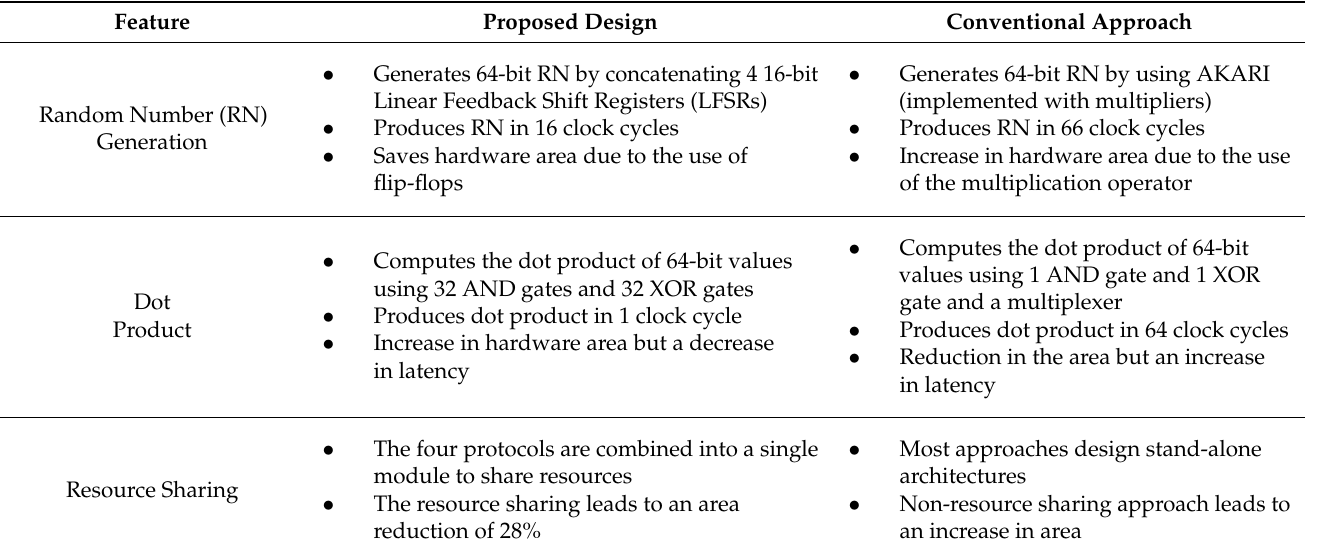
Table 2. Features of the lightweight authentication unit.